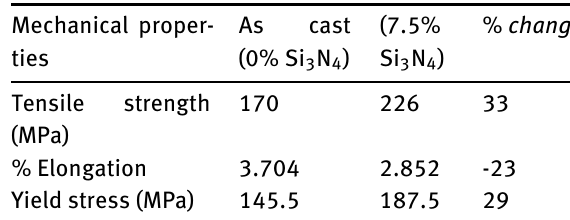
Table 3: Tensile test results of A and ASiN